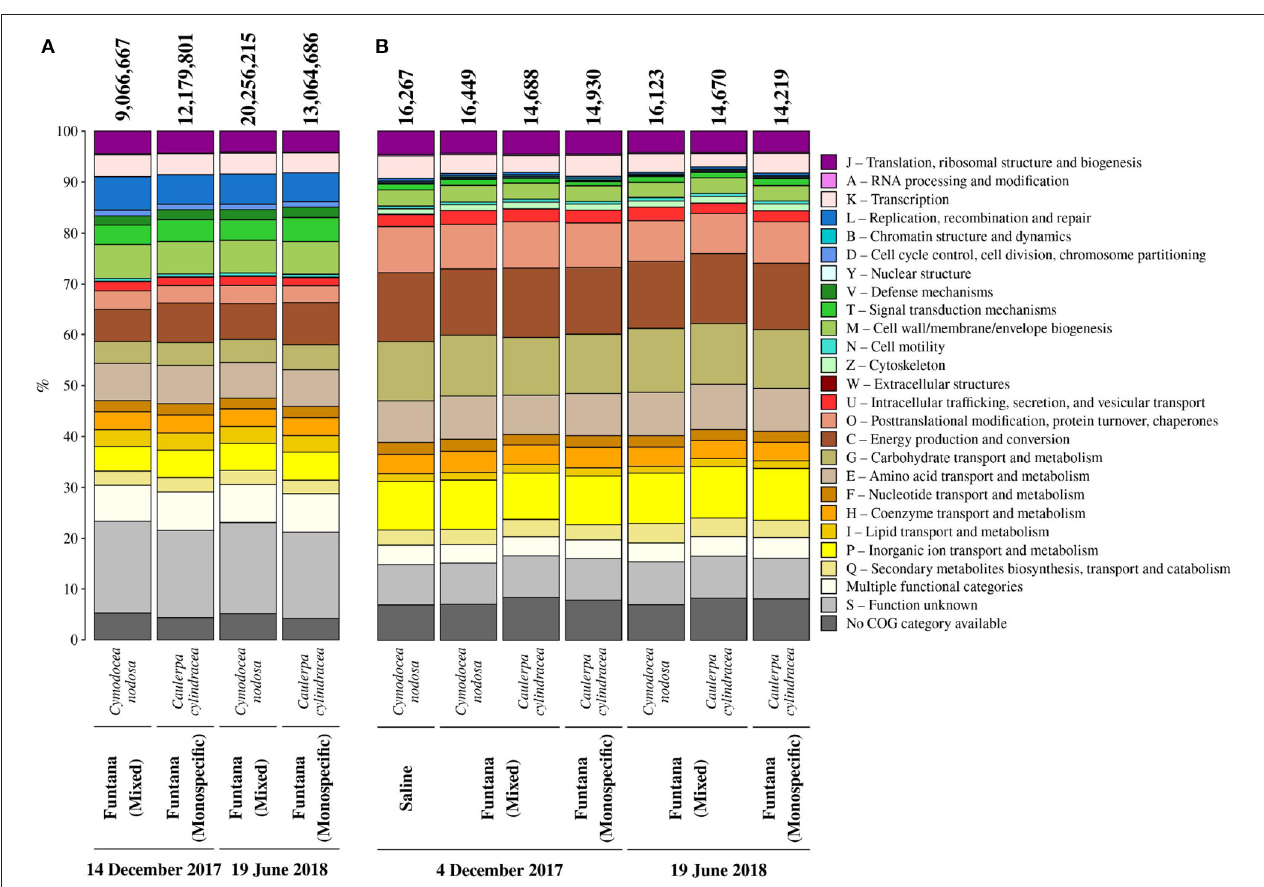
FIGURE 5 | Relative contribution of each COG (Clusters of Orthologous Groups) category to the total number of annotated coding sequences (A) from metagenomes and identified proteins (B) from metaproteomes associated with surfaces of two marine macrophytes ( C. nodosa and C. cylindracea ) sampled in the Bay of Saline and the Bay of Funtana (mixed and monospecific settlements) and in two contrasting seasons (December 4/14, 2017 and June 19, 2018). Total number of annotated coding sequences and identified proteins is given above the corresponding